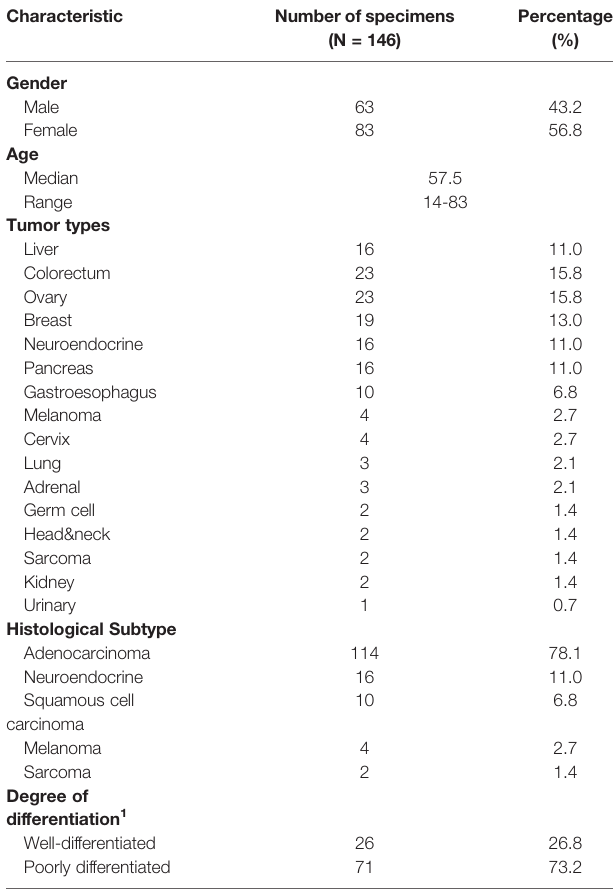
TABLE 1 | The demographics and clinical characteristics of the cohort.